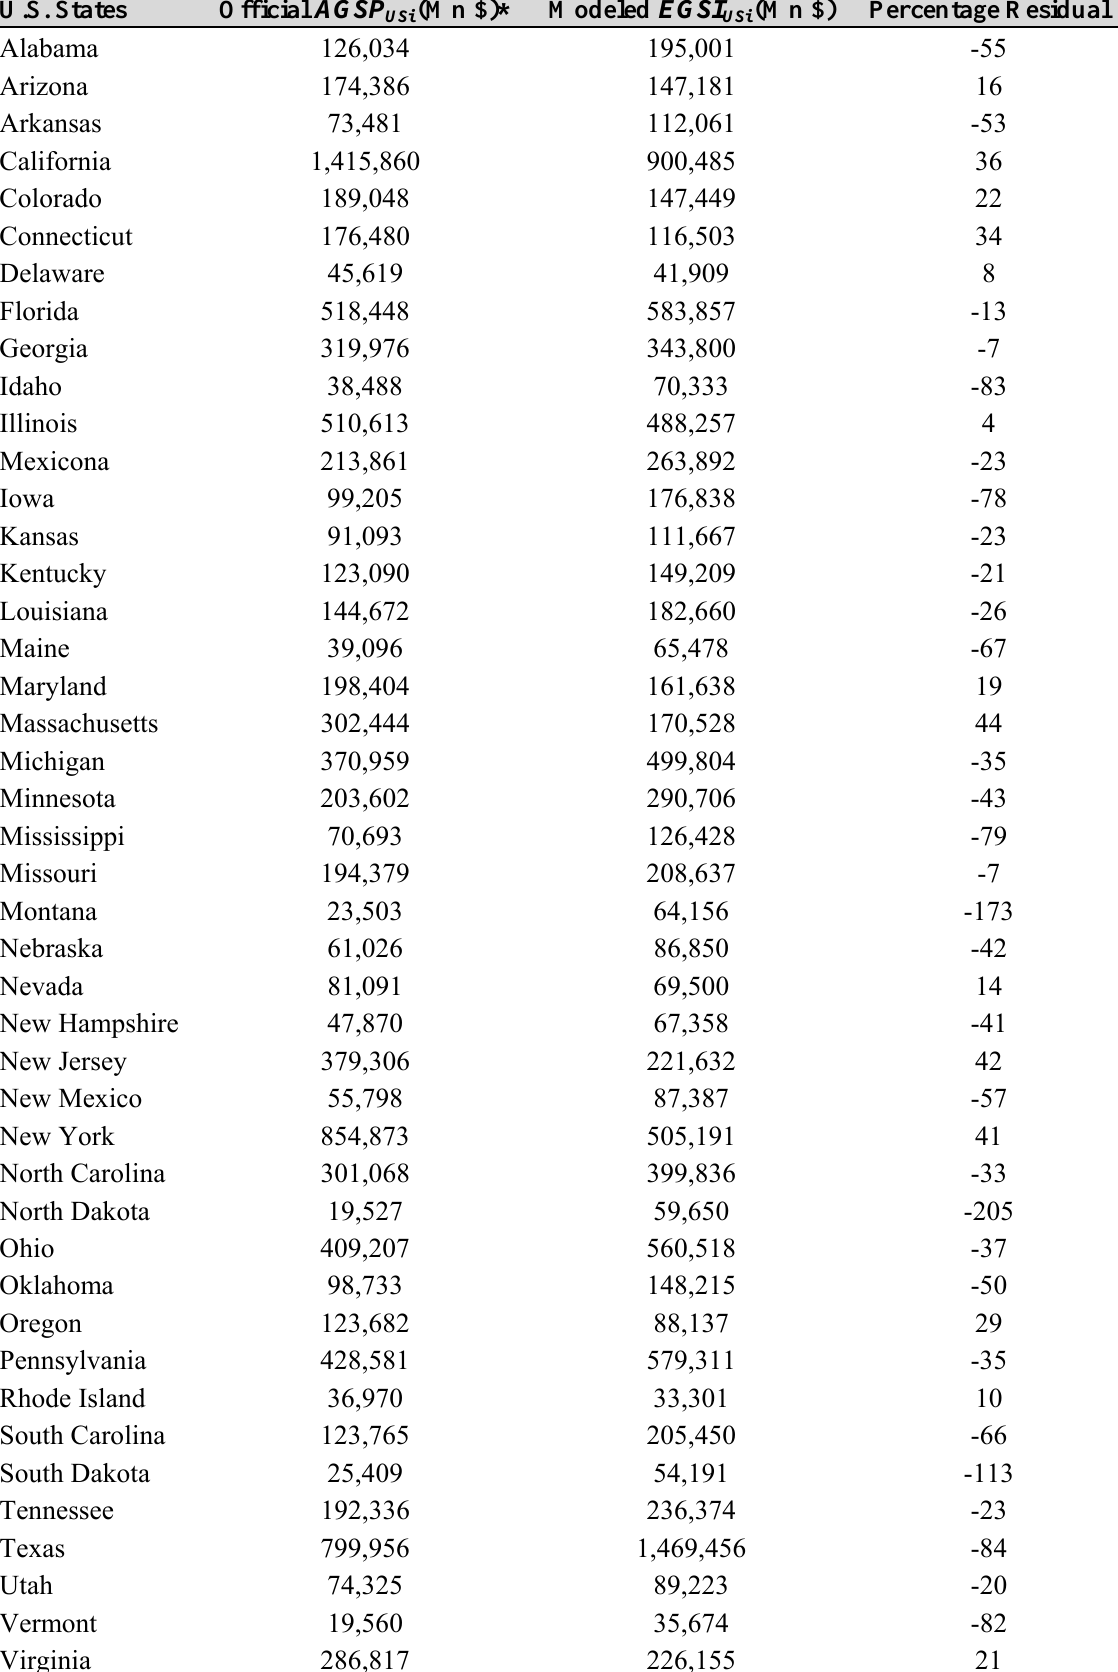
, Modeled EGSI , and Percentage Residual for each U.S. state. USi USi